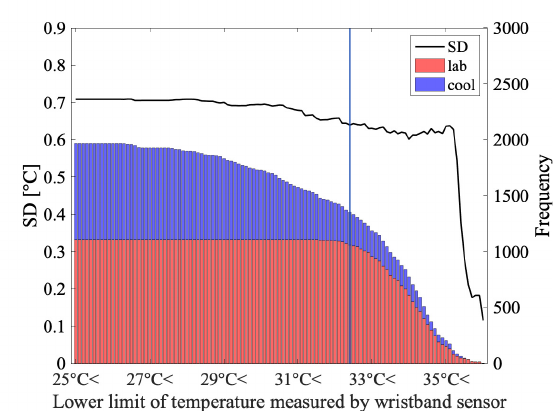
Figure 13. Relation between wristband measured temperature and SD of correction error.